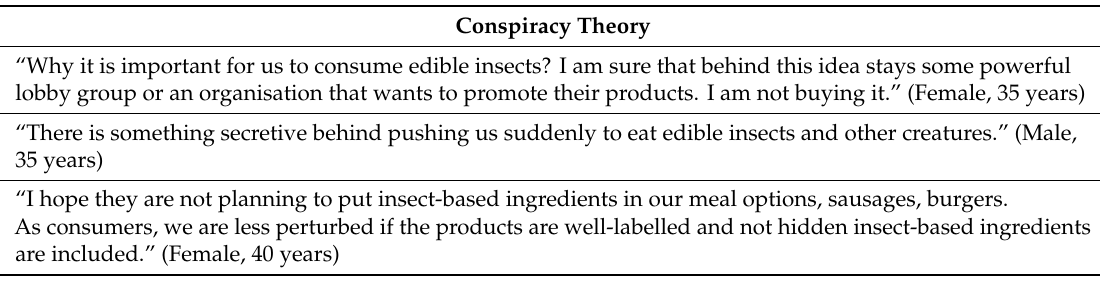
Table 5. Psychological factor: conspiracy